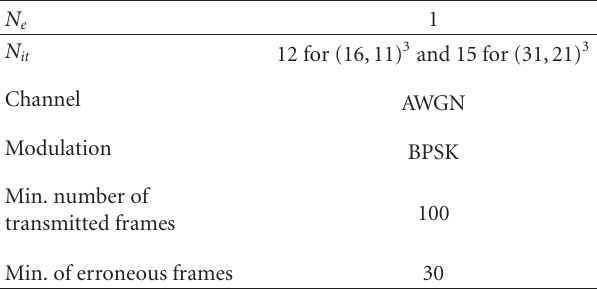
Table 1: Simulation default parameters.